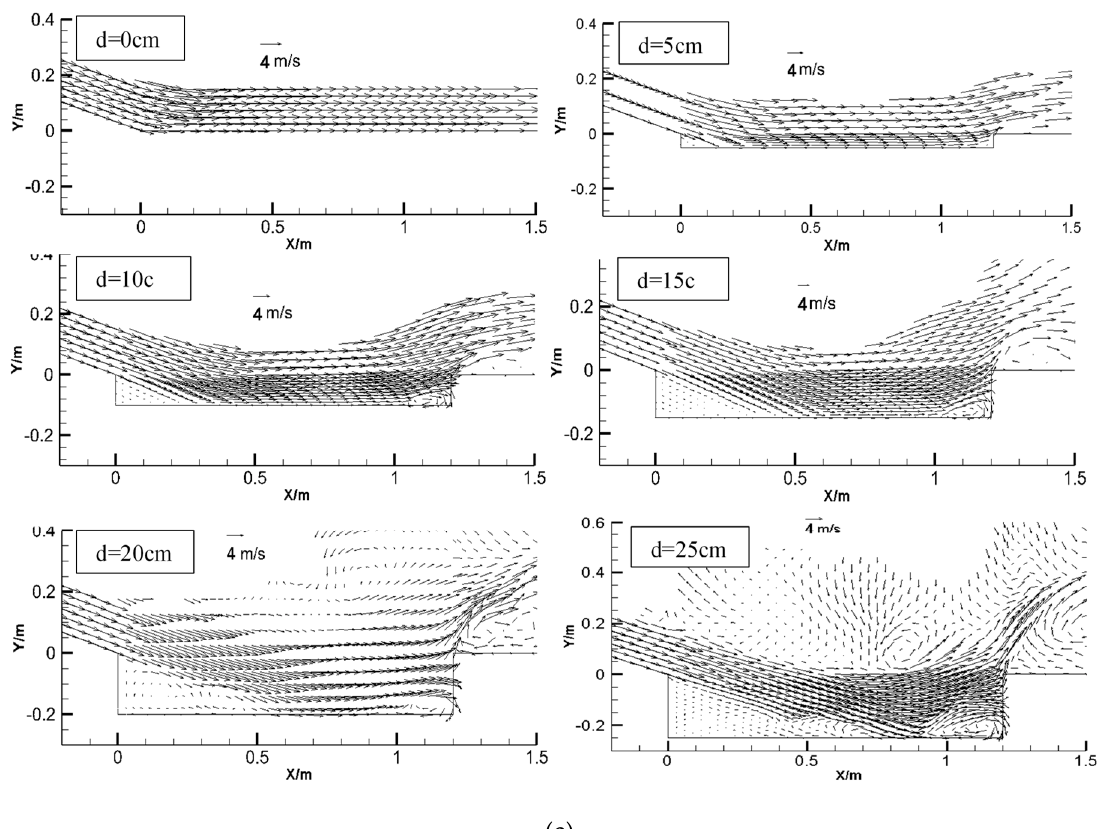
Figure 6. Flow regimes and velocity distribution at axial plane. ( a ) Fr = 6.92; ( b ) Fr = 7.64; ( c ) Fr = 8.05; ( d ) Fr = 9.25; ( e ) Fr = 11.24. Fr: Froude number.